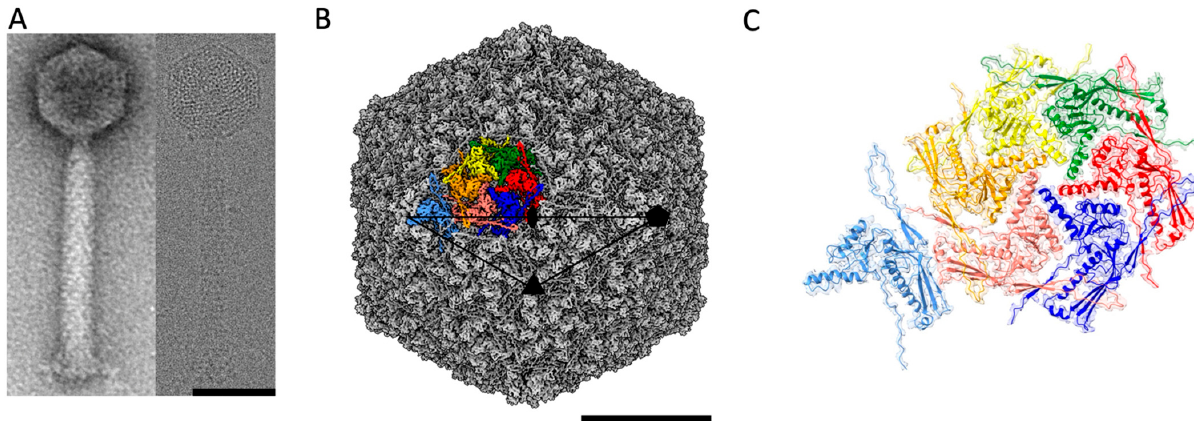
Figure 1. Cryo-EM structure of the φ RSA1 capsid. ( A ) View of a φ RSA1 mature phage imaged by negative stain (left panel) and cryo-EM (right panel). ( B ) Isosurface representation of the 3D reconstruction of the mature φ RSA1 capsid at 3.9 Å resolution. The position of the symmetry axis (2, 3 and 5-fold) of the icosahedral capsid are indicated. The black triangle delimits the asymmetric unit of the capsid. The seven quasi equivalent subunits of the capsid asymmetric unit are highlighted in different colors. ( C ) Zoomed view on the same asymmetric unit with the seven quasi equivalent subunits of the major capsid protein represented as ribbons fitted in their corresponding Coulomb potential density (in light transparent shade). The scale bars are 50 and 20 nm in ( A ) and ( B ) respectively.